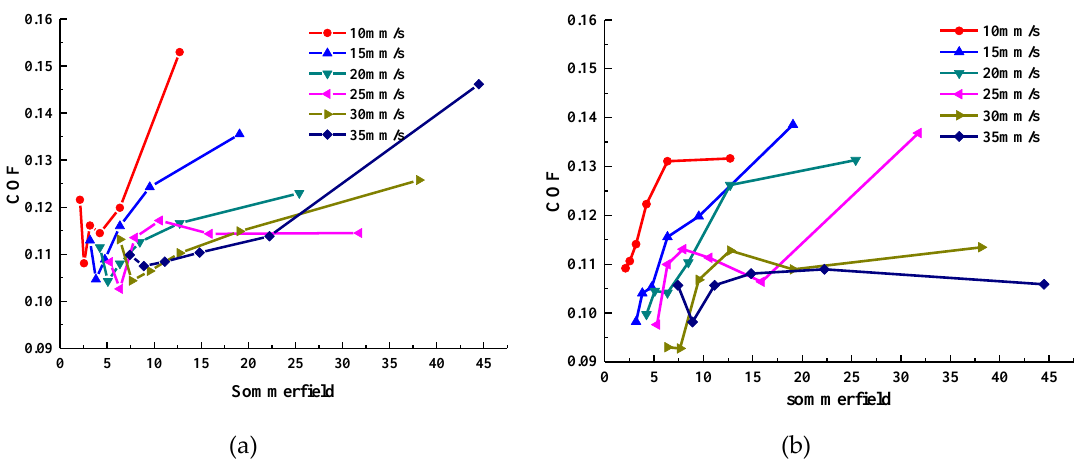
Figure 5. Comparison of Stribeck curves of sample oil at different sliding speeds: ( a ) sample oil #1; ( b ) sample oil #2.